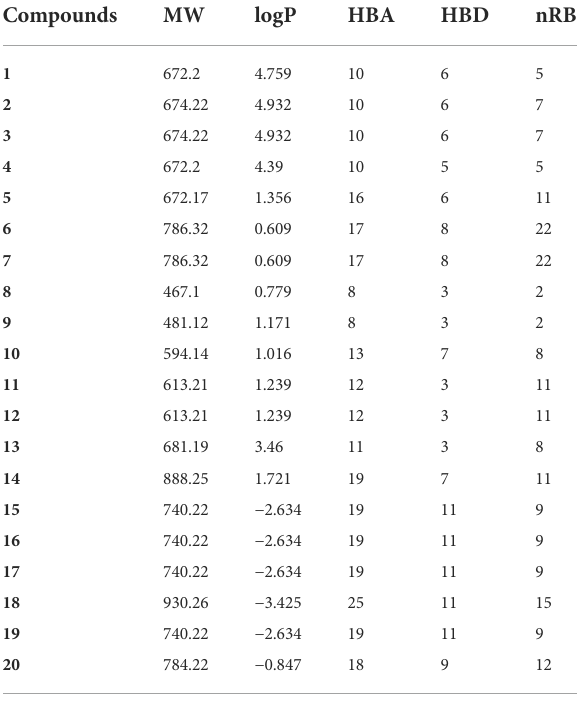
TABLE 5 Analysis of drug-like properties of the top 20 compounds screened by normalized assessment.